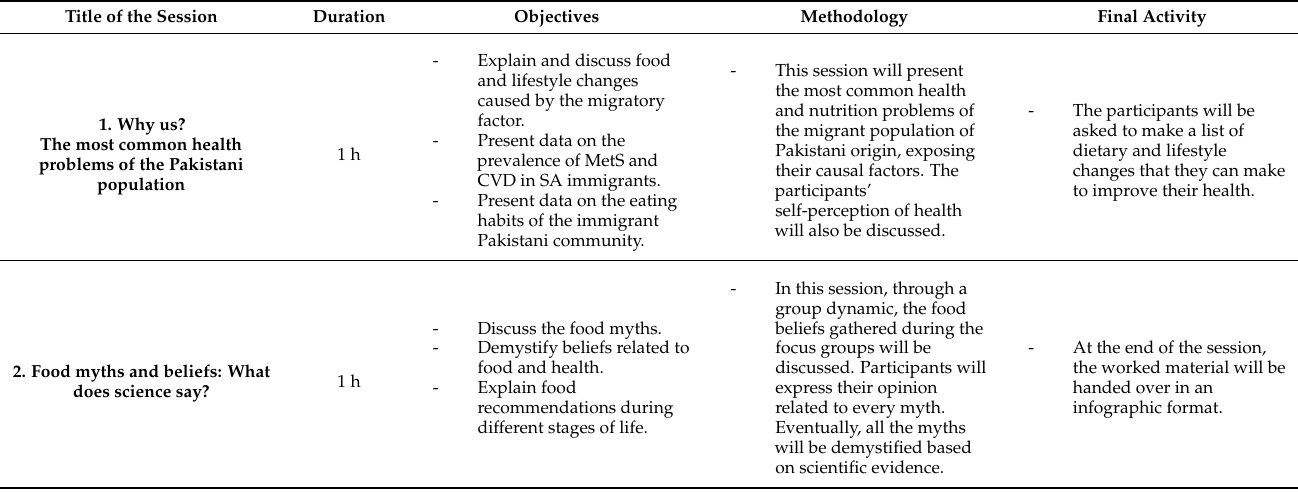
Table 3. Food education